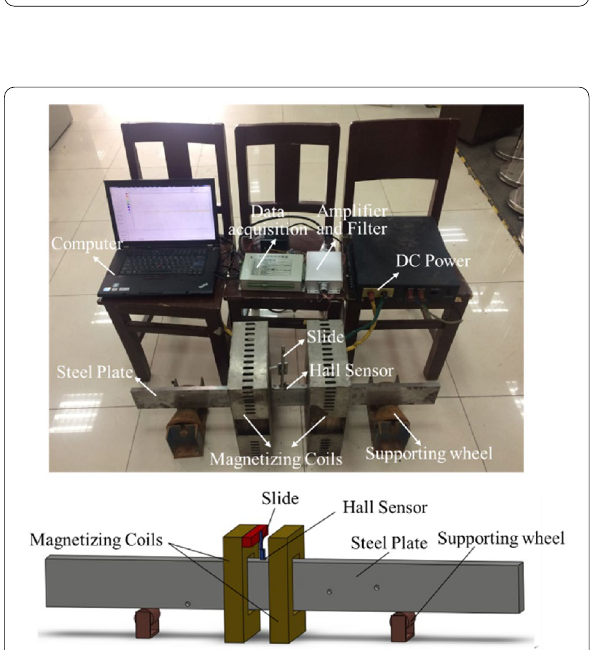
Figure 10 Schematic diagram of MFL testing for inner defects with different buried depths